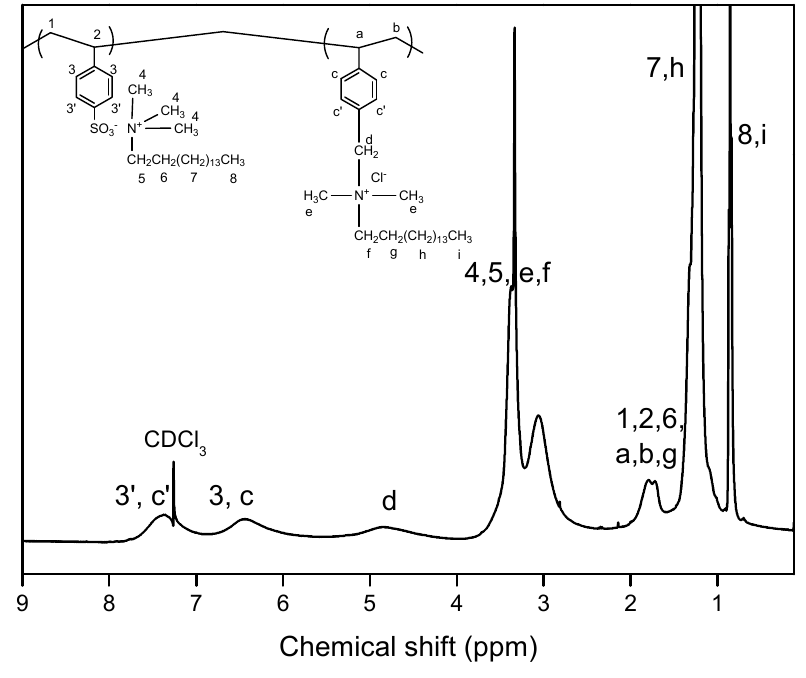
Figure 2. 1 H-NMR spectrum of P(SSAmC 16 -co-VBCHAM65).